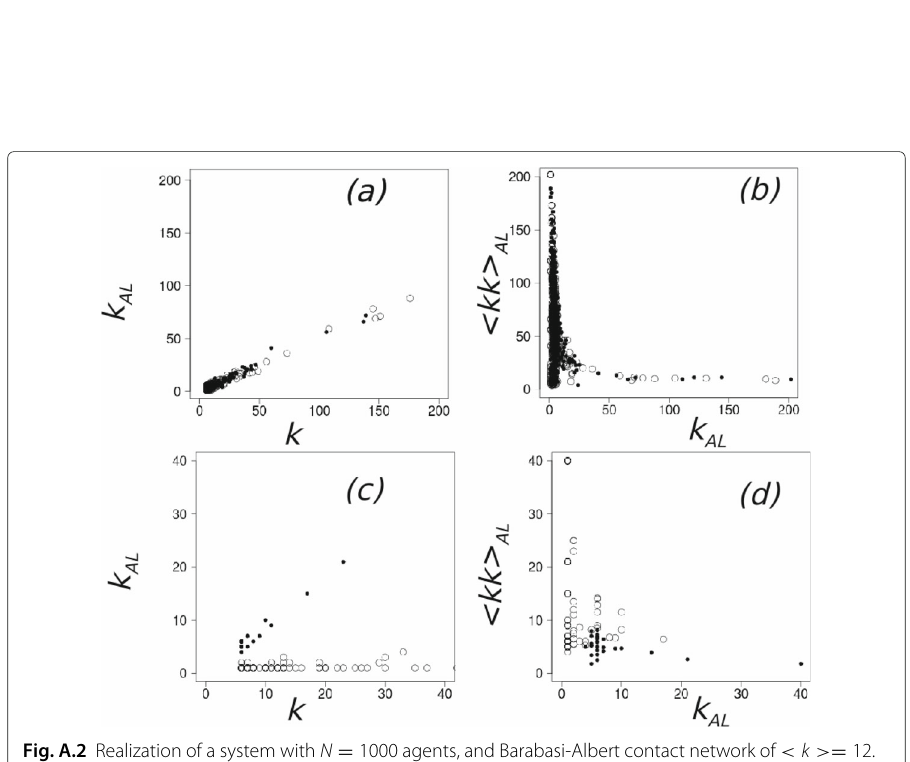
Fig. A.2 Realization of a system with N = 1000 agents, and Barabasi-Albert contact network of < k > = 12. Left panels a , c : Degree of the nodes in G AL ( k AL ) versus the degree of the nodes in the underlying static network ( k ). Right panels b , d : degree correlation of G AL for each agent of G AL . Upper panels a and b correspond to ρ = 0.49. Lower panels c and d correspond to ρ =